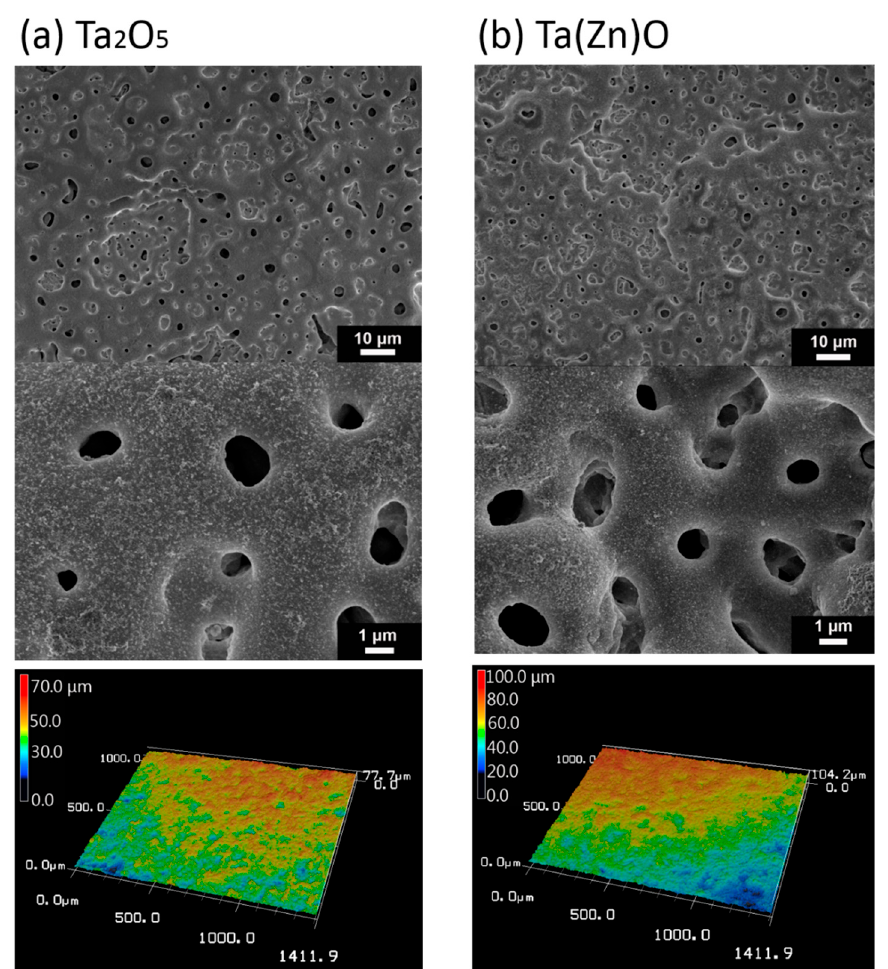
Figure 2. SEM images and 3D surface morphologies of the ( a ) Ta 2 O 5 and ( b ) Ta(Zn)O coated titanium samples.